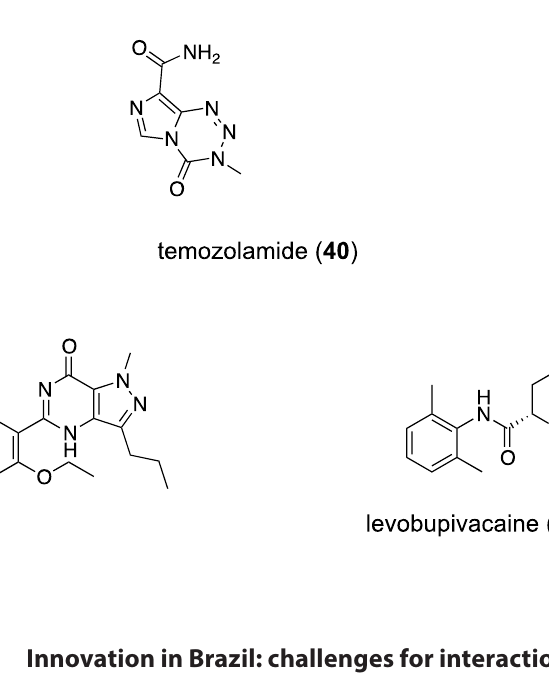
FIGURE 5 - Examples of drugs agents developed through university-business